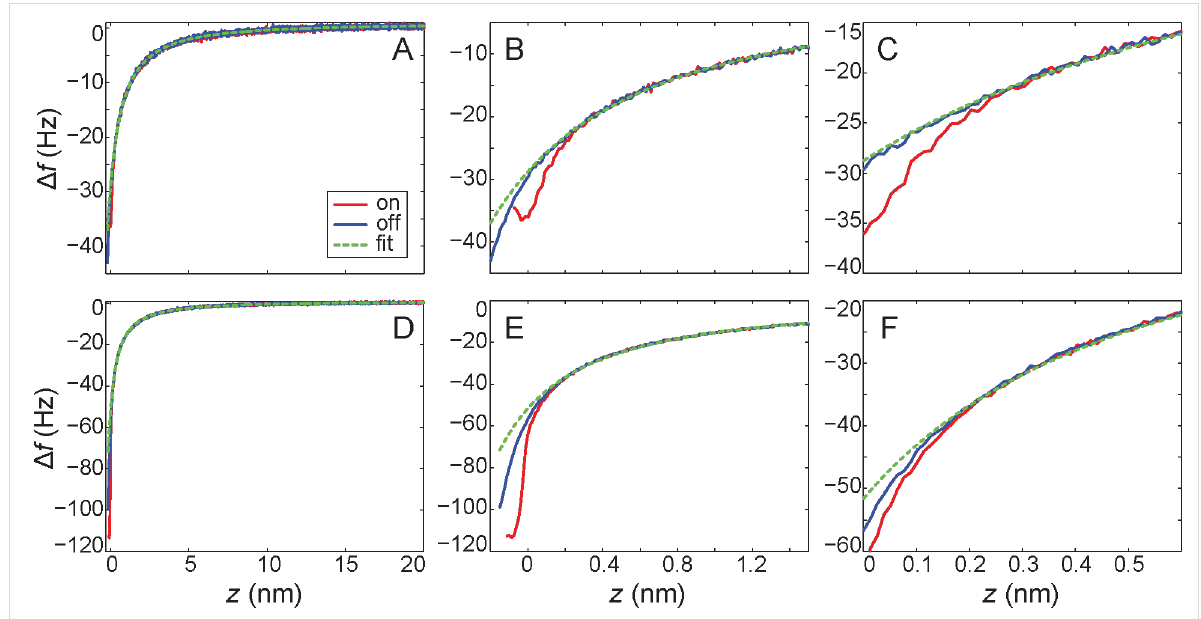
Figure 3: Close inspection of the divergence point between the ‘on’ and ‘off’ curves for A)–C) tip–C 60 interaction, and D)–F) tip–Si interaction. Also plotted is the long-range fit for a cut-off of +0.1 nm which resulted in the short-range forces plotted in Figure 2. A)–C) shows the same data plotted on three different axis scale to show A) the long-range behaviour of the fit, B) the behaviour in the short-range regime, and C) the divergence point of the ‘on’ and ‘off’ curves. D)–E) shows the same progression for the tip–Si